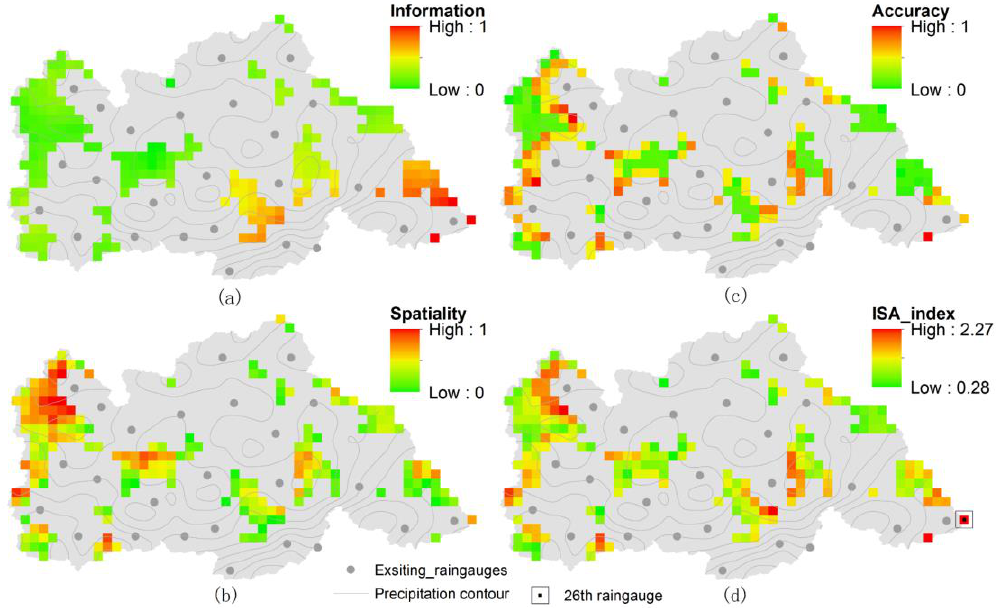
Figure 10. Screening for the 26th rain gauge. ( a – d ) are the distribution of the total information content, spatiotemporality, accuracy, and ISA components after potential points join the network.